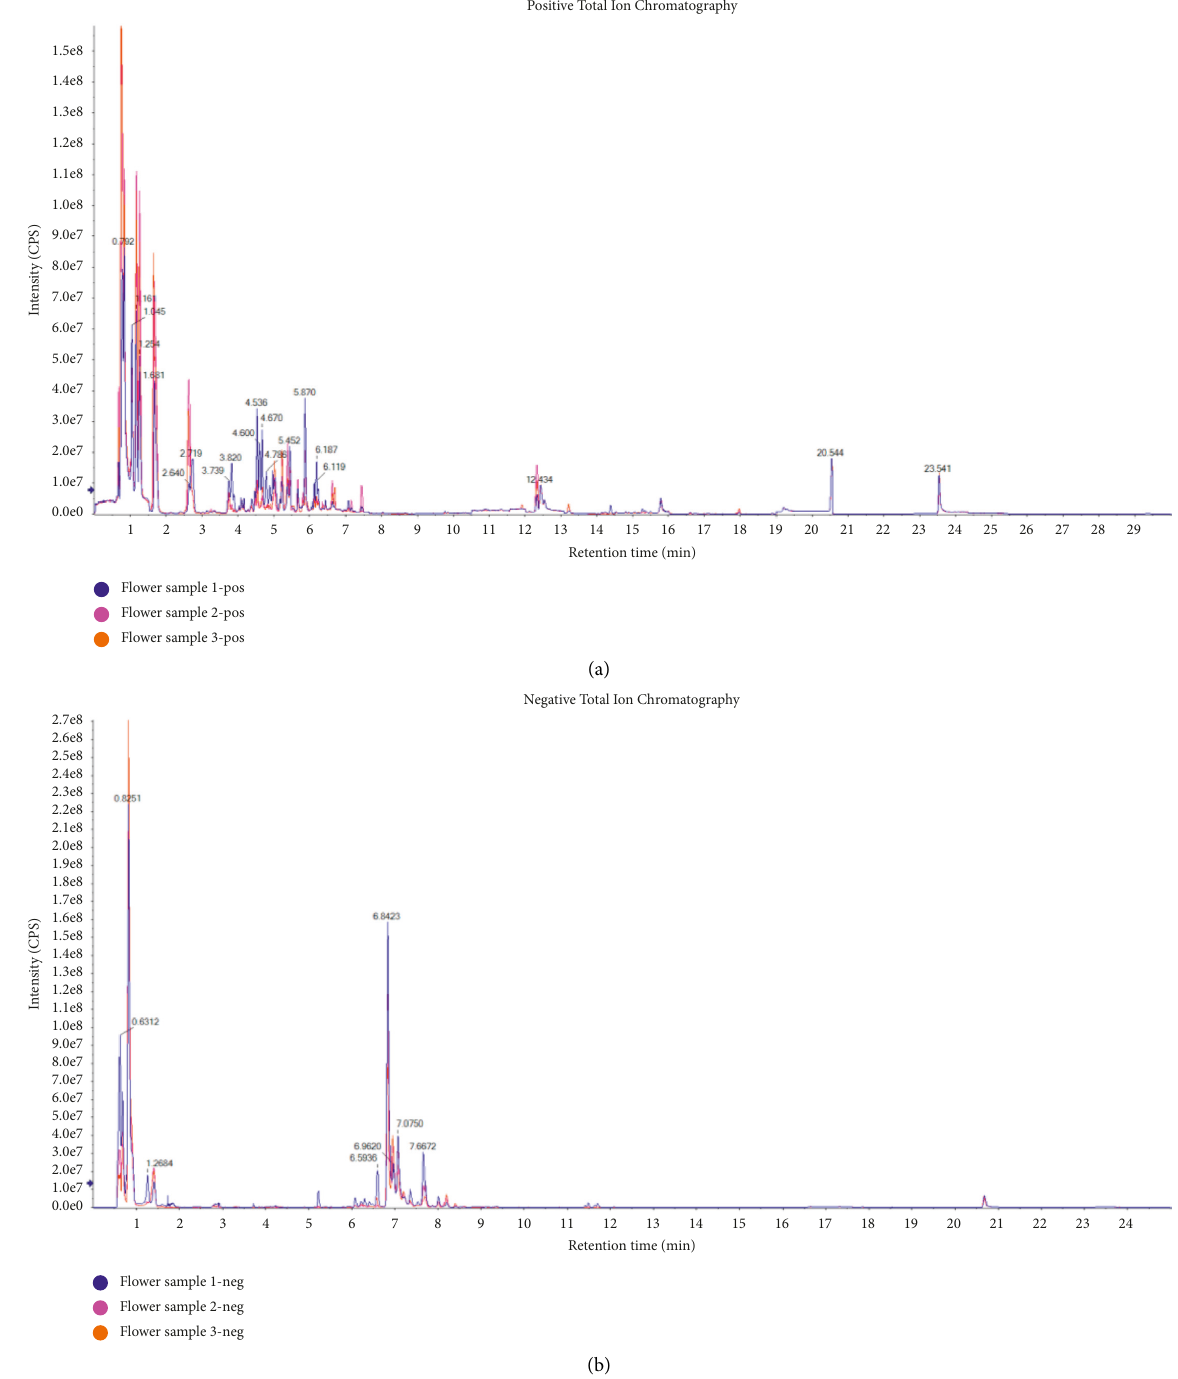
Figure 2: HPLC-MS/MS total ion chromatograms of extracts from flower of D. nobile . (a) Positive ion mode. (b) Negative ion